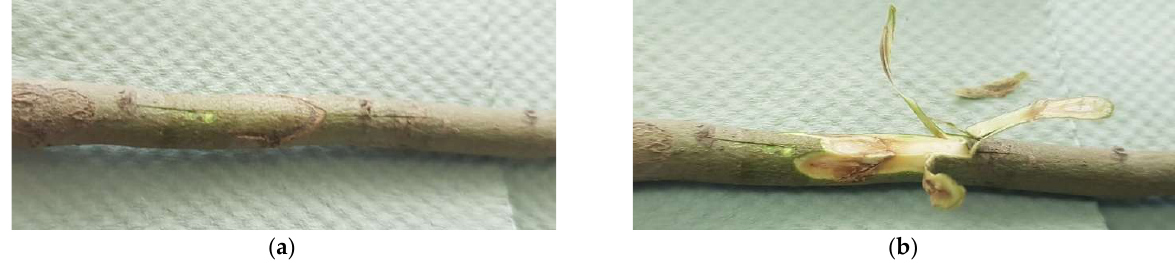
Figure 2. Samples of saplings watered with BTHWA prior to inoculation (W2) in general view ( a ) and cross section ( b ).